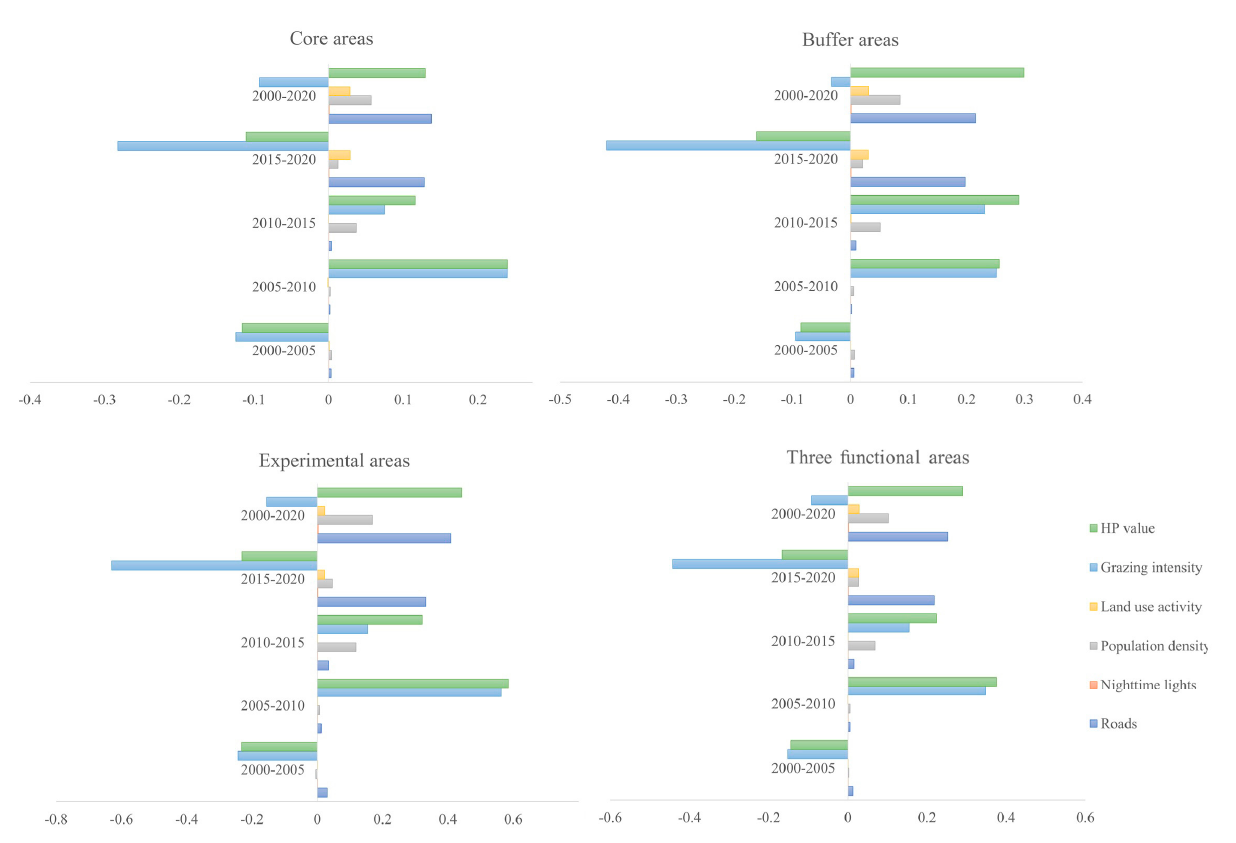
Figure 7. Changes in HP in various functional areas of the NRs for 2000–2020.